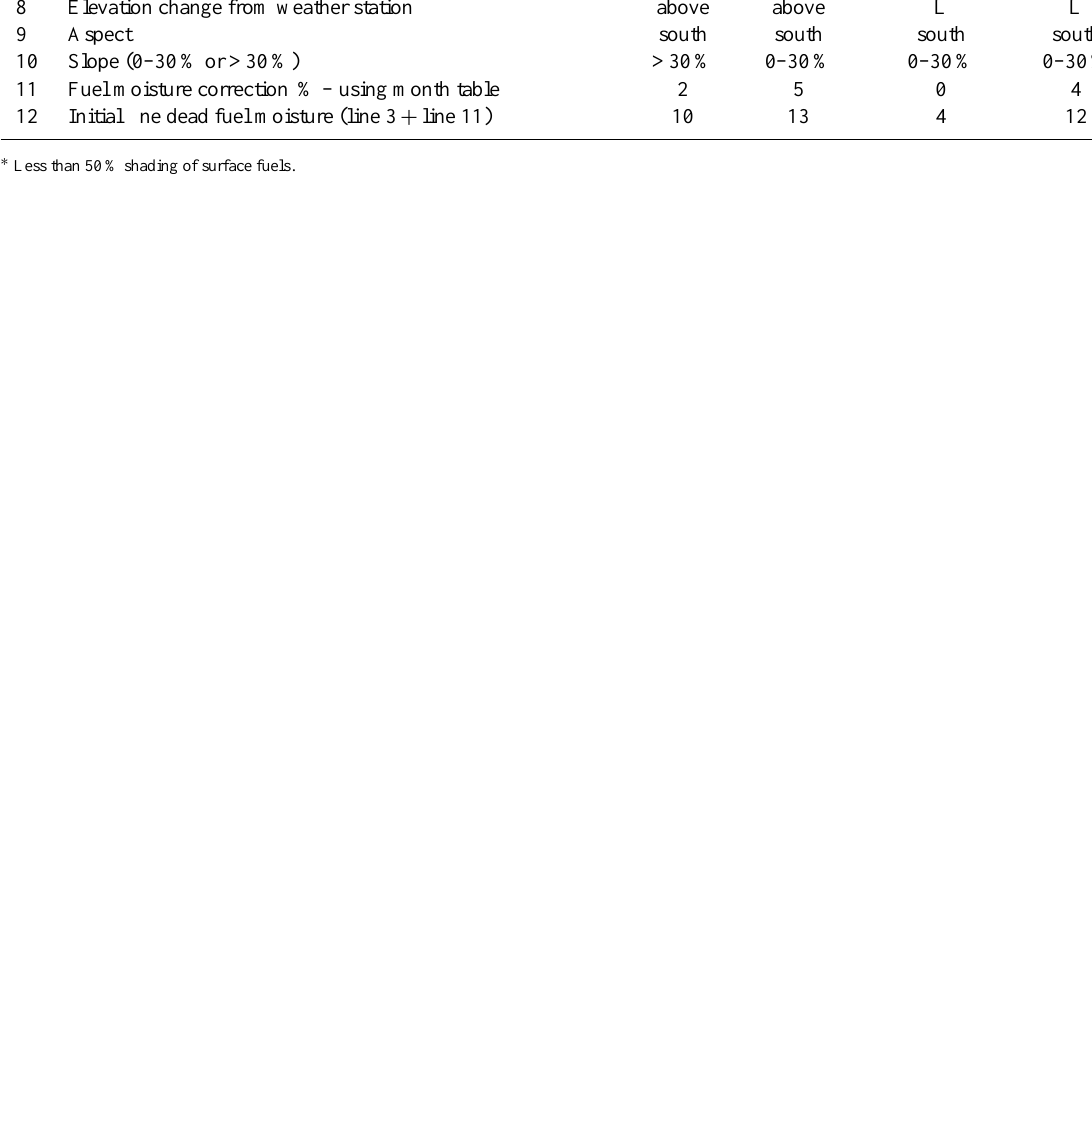
Table to be used (Rothermel, 1983, p.